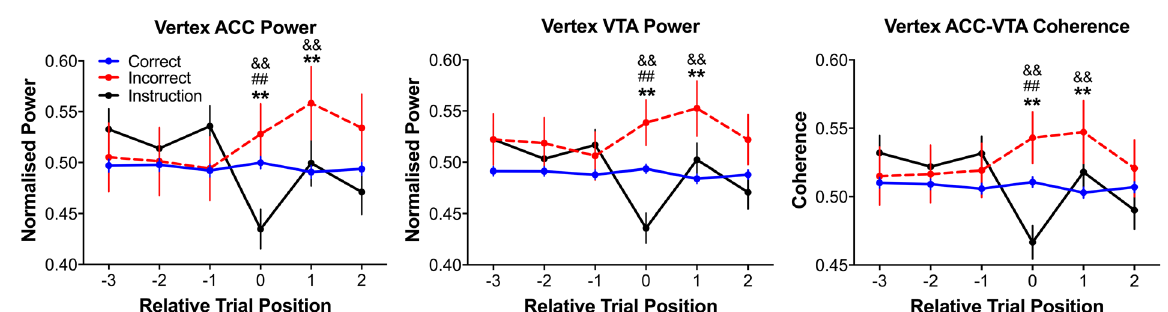
Figure 6. Changes relative to trial types of interest in ACC and VTA 4 Hz power and coherence. Trial position 0 in these plots indicates the normalised residual vertex mean of all trials of each type for each dependent measure, respectively. The data represented at trial position 1 are the vertex means of all trials immediately after each trial that was used in trial position 0. Other trial position data were calculated in a similar fashion. Consistent with the linearized results, vertex ACC and VTA 4 Hz power and coherence were greatest during incorrect choice trials as compared to during instruction and correct choice trials. ACC and VTA 4 Hz power and coherence were elevated in the vertex region as the animal made a post-error correct choice. These data from phase A1 are presented as mean ± SEM of all normalised residual data where the normalisation was relative to the vertex. ** Indicates that correct choices were significantly different from incorrect choices at the p < 0.005 significance level via multiple comparisons tests; && indicates that incorrect and instruction trials were significantly different at the p < 0.005 significance level via multiple comparisons tests; ## Indicates that correct choices and instruction trials were significantly different at the p < 0.005 significance level via multiple comparisons tests. See also Fig. S4 for data processed without the regression